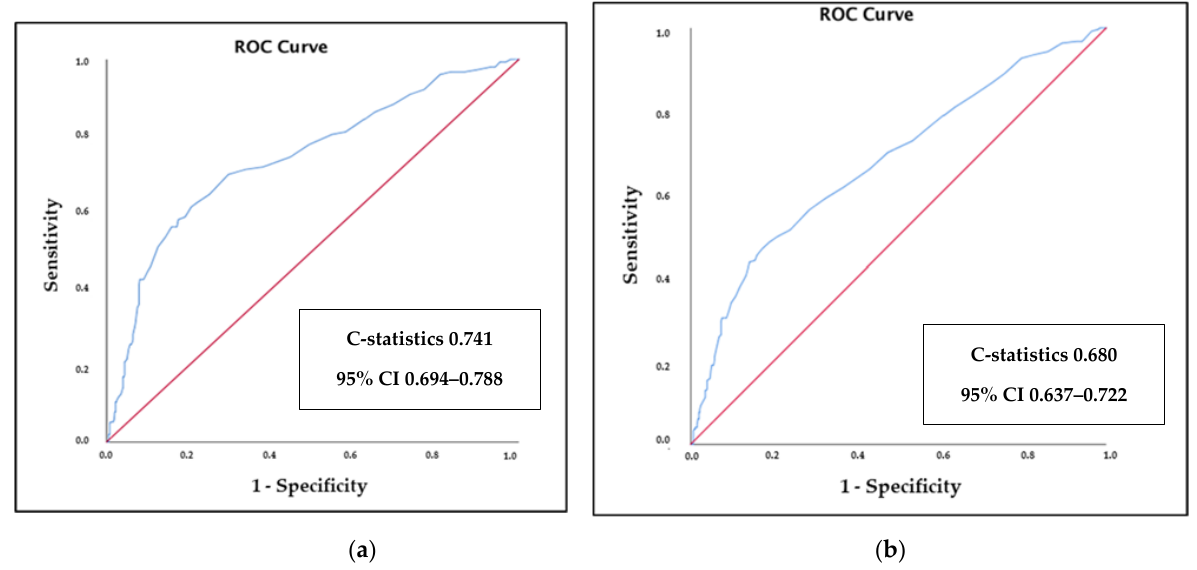
Figure 2. ( a ) ROC curve for mortality according to RDW. ( b ) ROC curve for composite endpoint according to RDW.